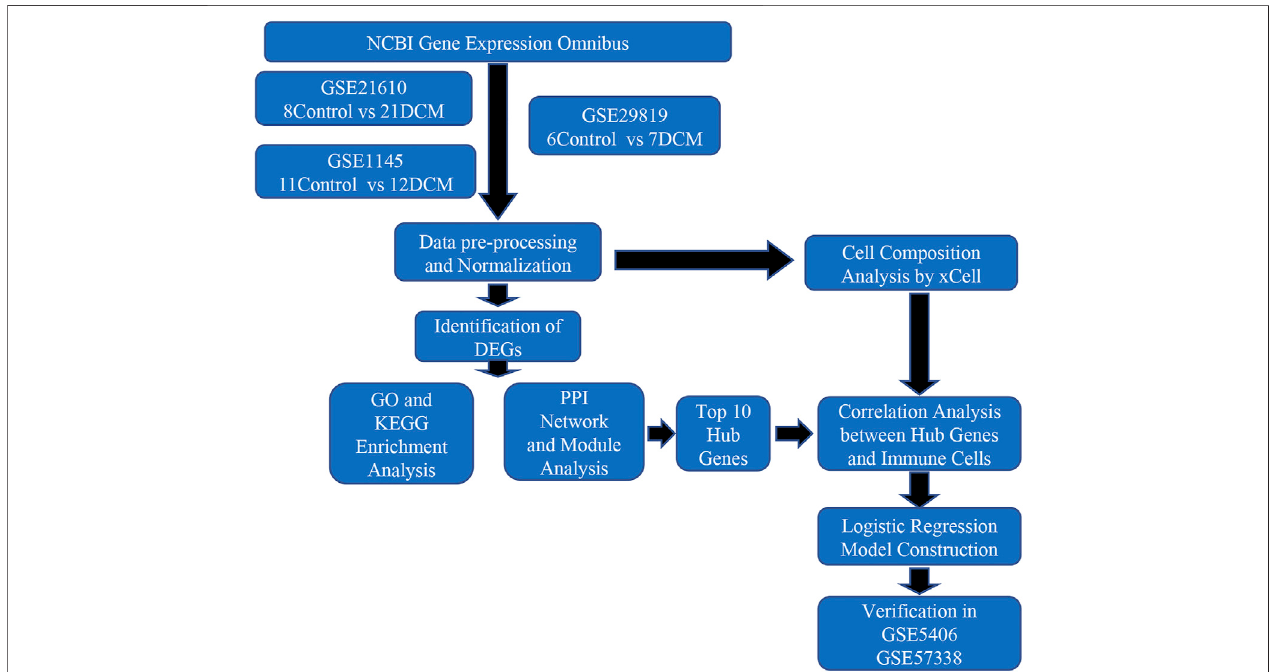
FIGURE 1 | Flowchart of the